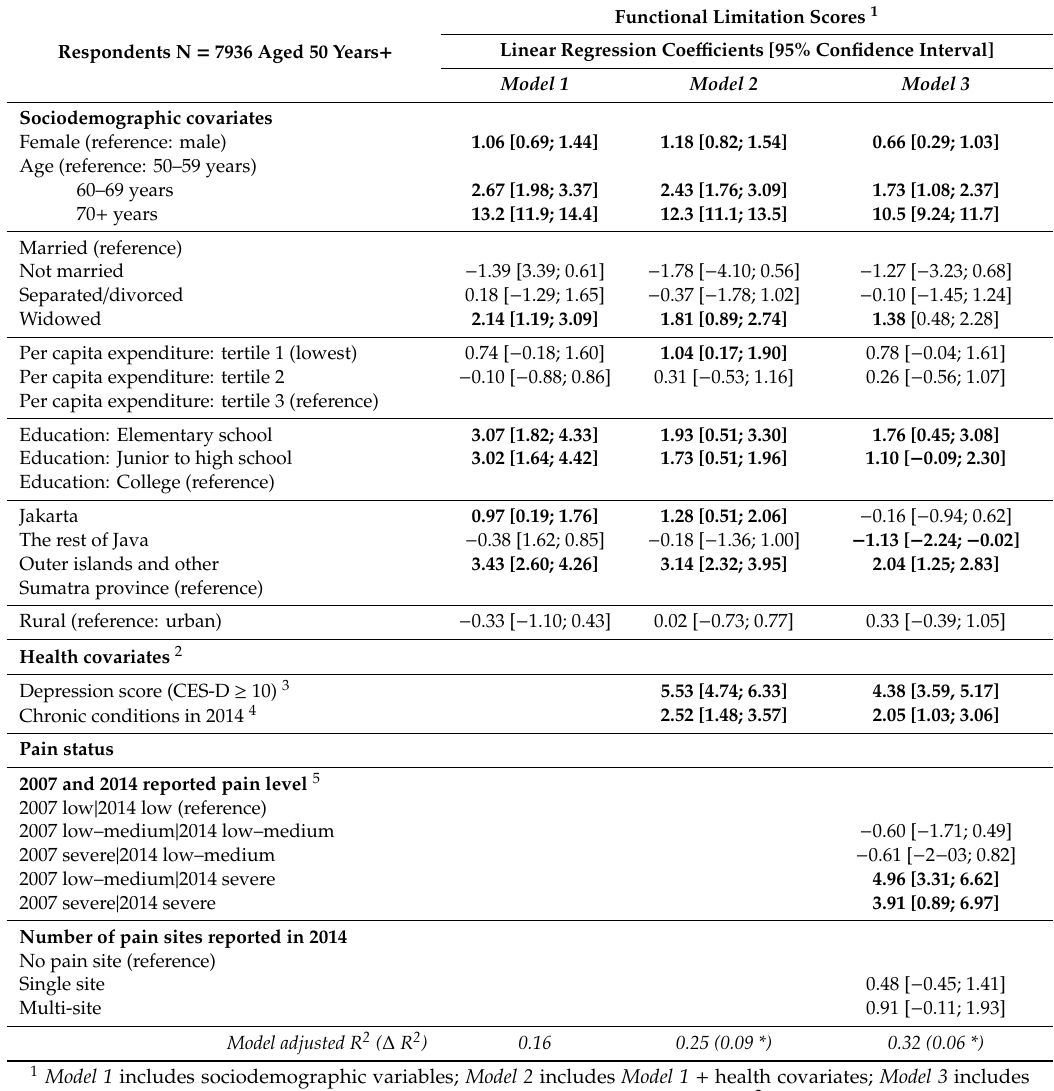
Table 3. Pain status (2007 and 2014) and functional limitation scores (2014), IFLS 2007 and